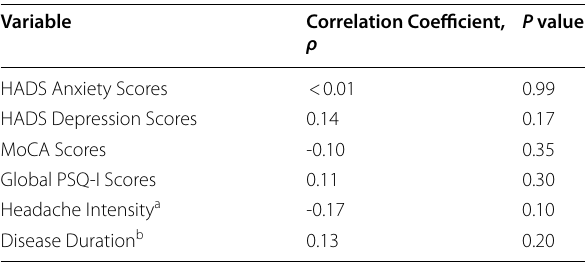
Table 3 Correlations of White Matter Hyperintensities with Anxiety, Depression, Mild Cognitive Impairment, Poor Quality of Sleep, Headache Intensity, and Disease Duration in Persistent Post‑Traumatic Headache ( n =